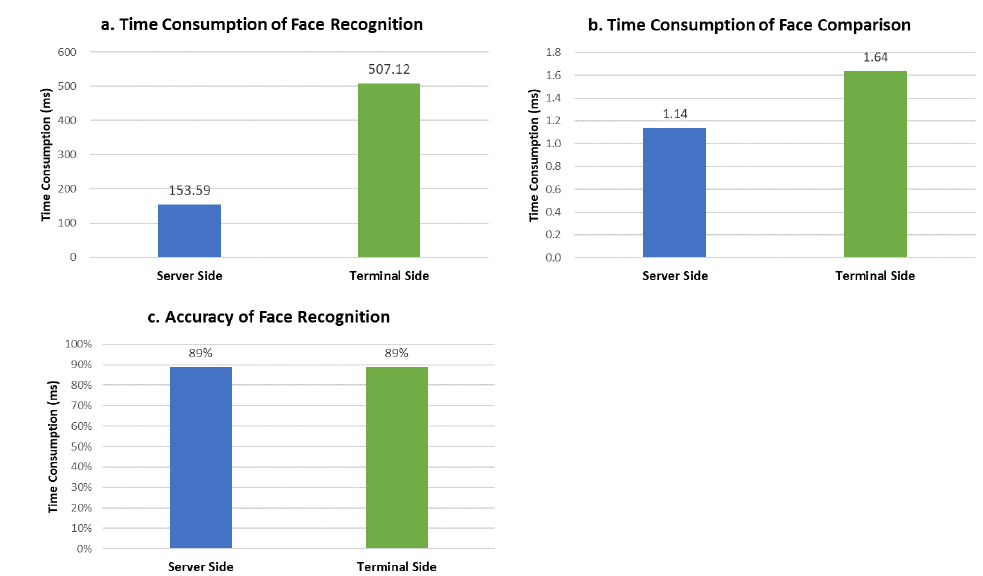
Figure 7. Performance Difference between Terminal TEE and Server